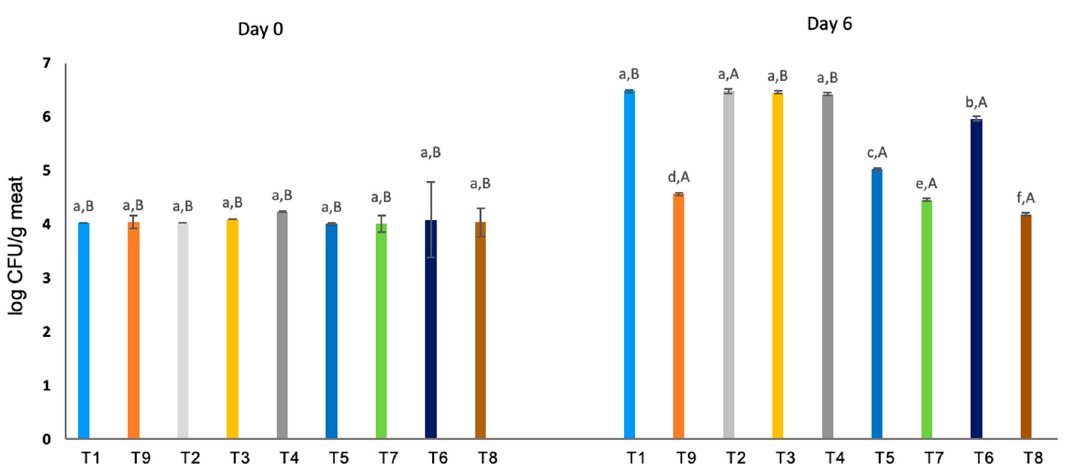
Figure 1. Microbiological analysis at days 0 and 6 in beef patties in refrigerated storage at 4 °C. Results are given with standard error. Different small letters, a–f , across the same day indicate significant differences between samples and different capital letters, A,B , in the same sample indicate significant differences between days. T1: CM (control), T2: 2% PSW, T3: 4% PSW, T4: 0.35% CA, T5: 2% RS, T6: 2% PSW + 0.35% CA, T7: 2% PSW + 0.35% CA + 2% RS, T8: 4% PSW + 0.35% CA + 2% RS and T9: 0.7% CAMPA N.3 (A).